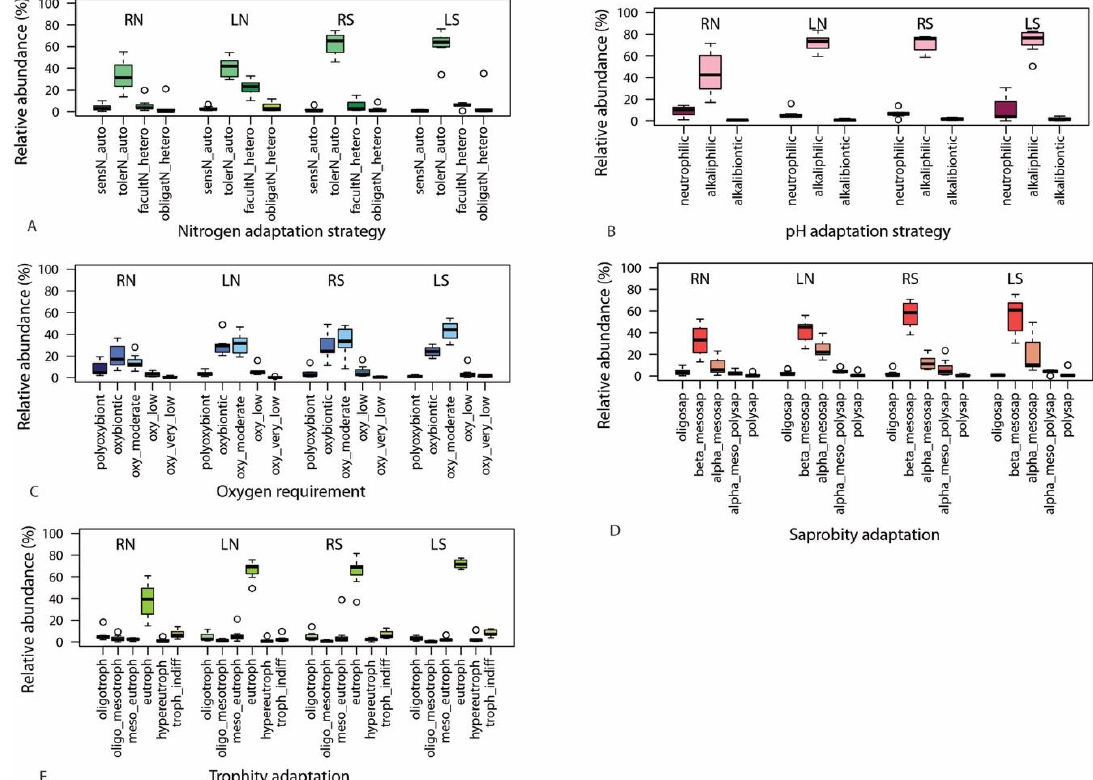
Figure 7. Boxplots illustrating relative abundances of the categories of traits defined by van Dam et al. [22] in samples from the four sampling points (RN = upstream, right bank, LN = upstream, left bank, RS = downstream, right bank, LS = downstream, left bank). ( A ) Nitrogen adaptation strategy, ( B ) pH adaptation strategy, ( C ) oxygen requirement, ( D ) saprobity, ( E )